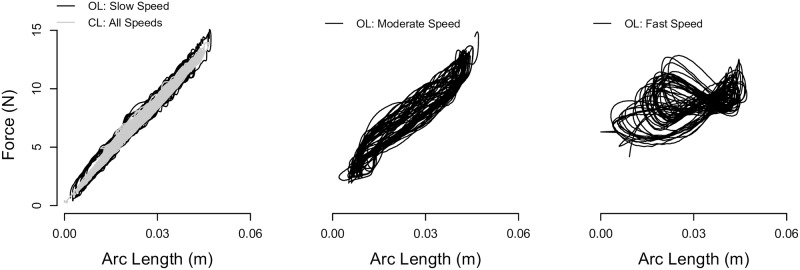
Sample interaction data.Example force versus arc length data when the force-feedback device rendered the standard Stiffness signal with no added haptically rendered noise using a closed-loop (CL) and open-loop (OL) controller and the experimenter pressed using slow, moderate, and fast interaction speeds.